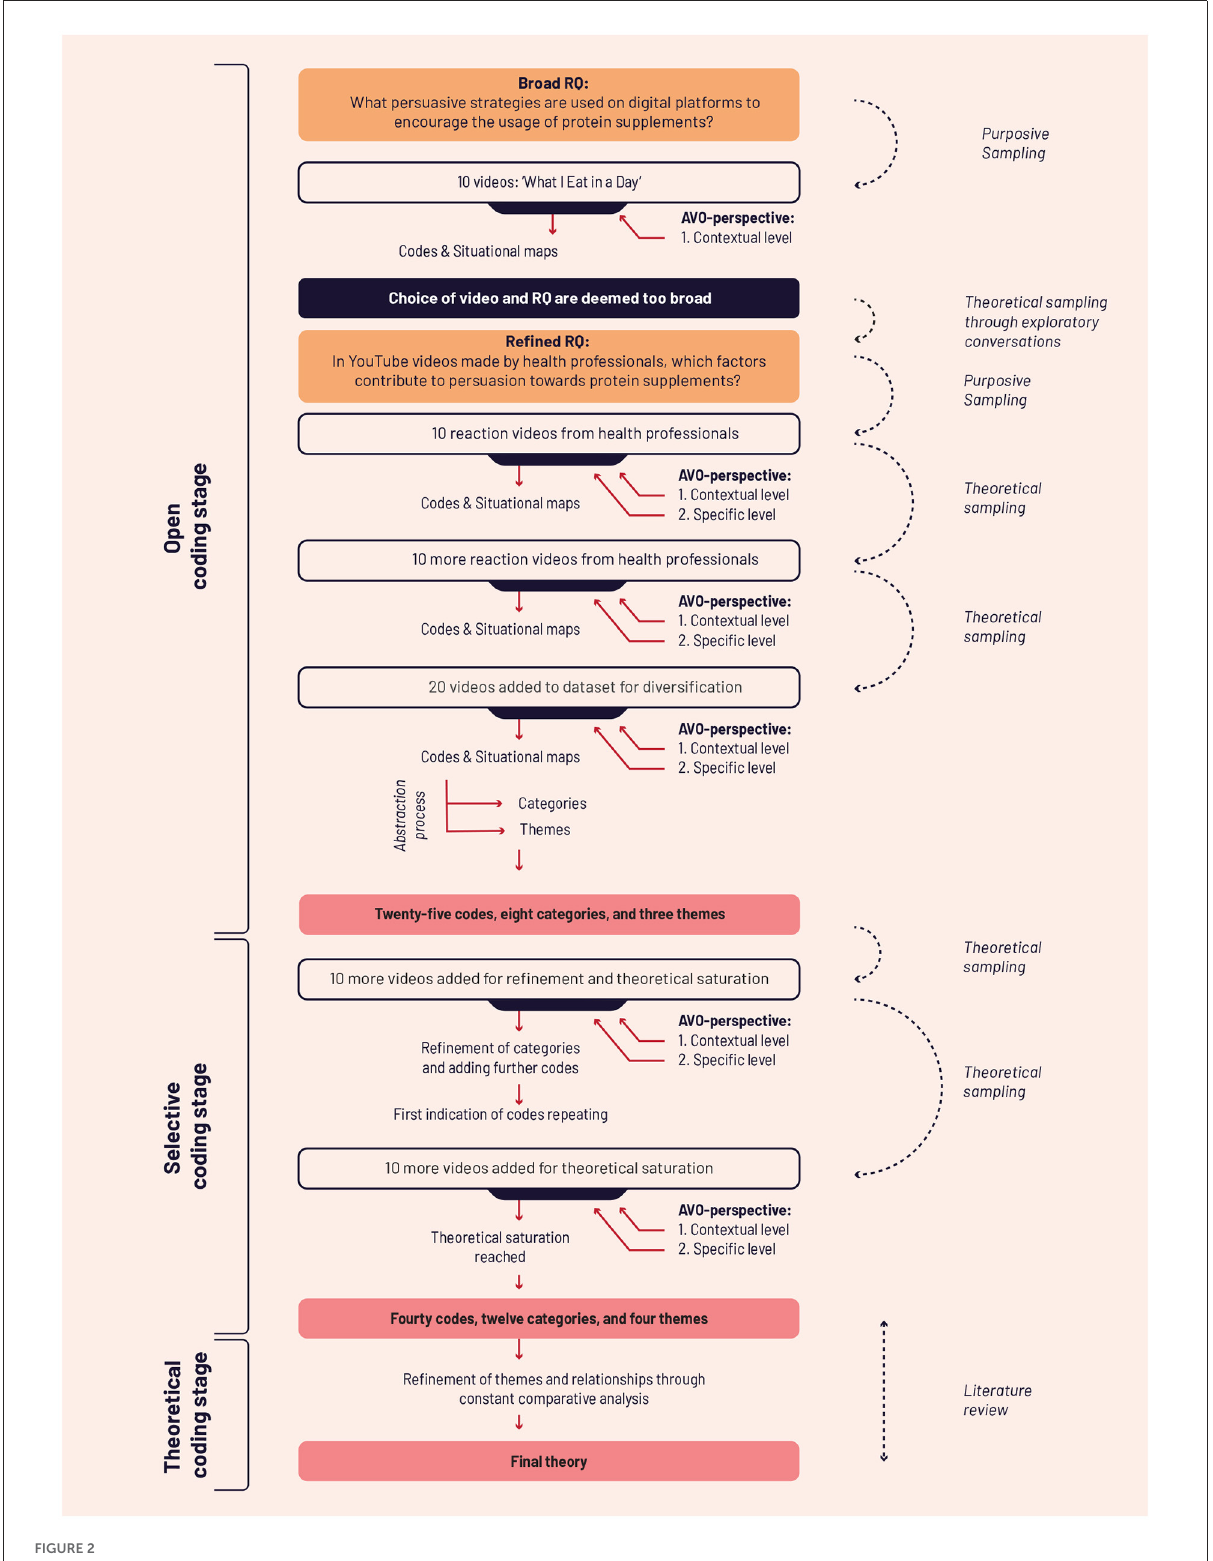
FIGURE2 The complete data collection and analysis process of this